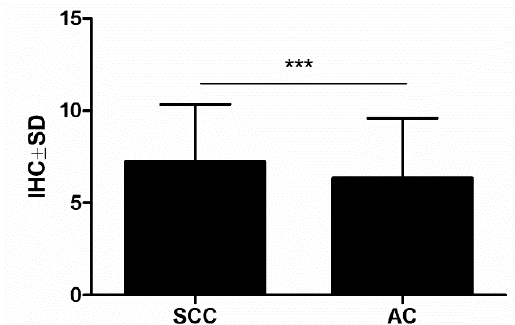
Figure 2. Expression levels of periostin (POSTN) in the tissue of two non-small cell lung carcinoma (NSCLC) subtypes: squamous cell cancer (SCC) and adenocarcinoma (AC) (*** p < 0.001); Mann–Whitney U test.